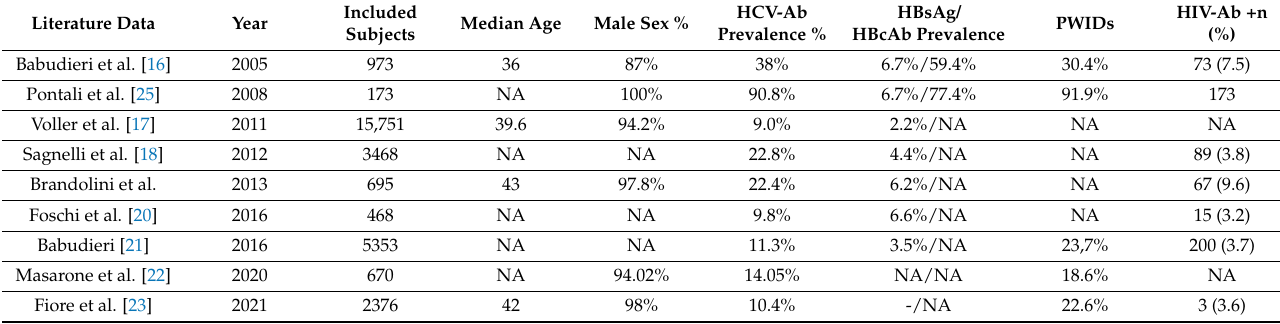
PWIDs: people who inject